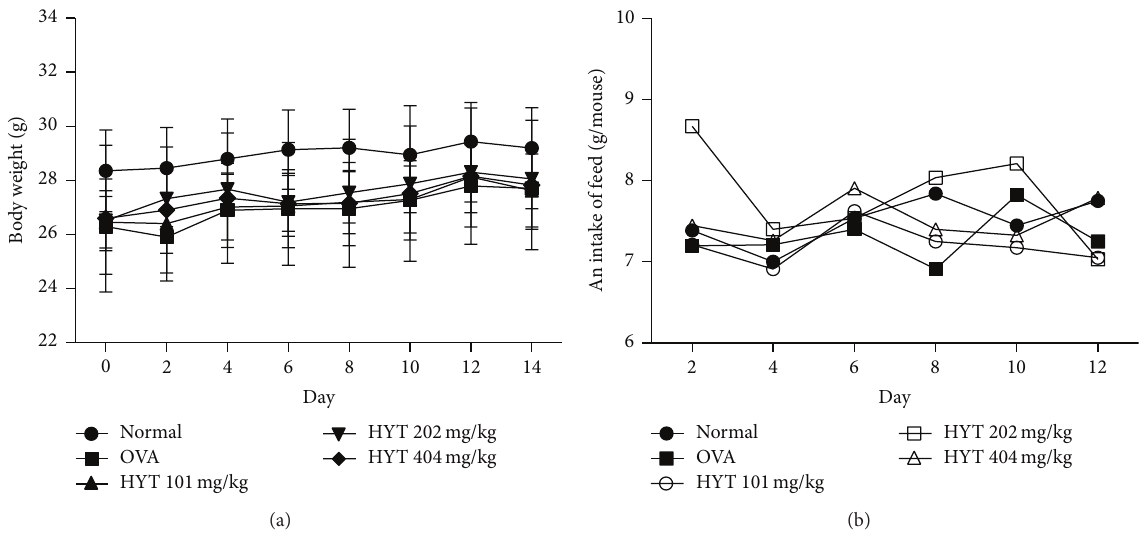
Figure 2: Changes in body weight (a) and food intake (b) during treatments with HYT in OVA-induced AR mice model. Values are expressed as mean ± SEM ( 𝑛 = 8